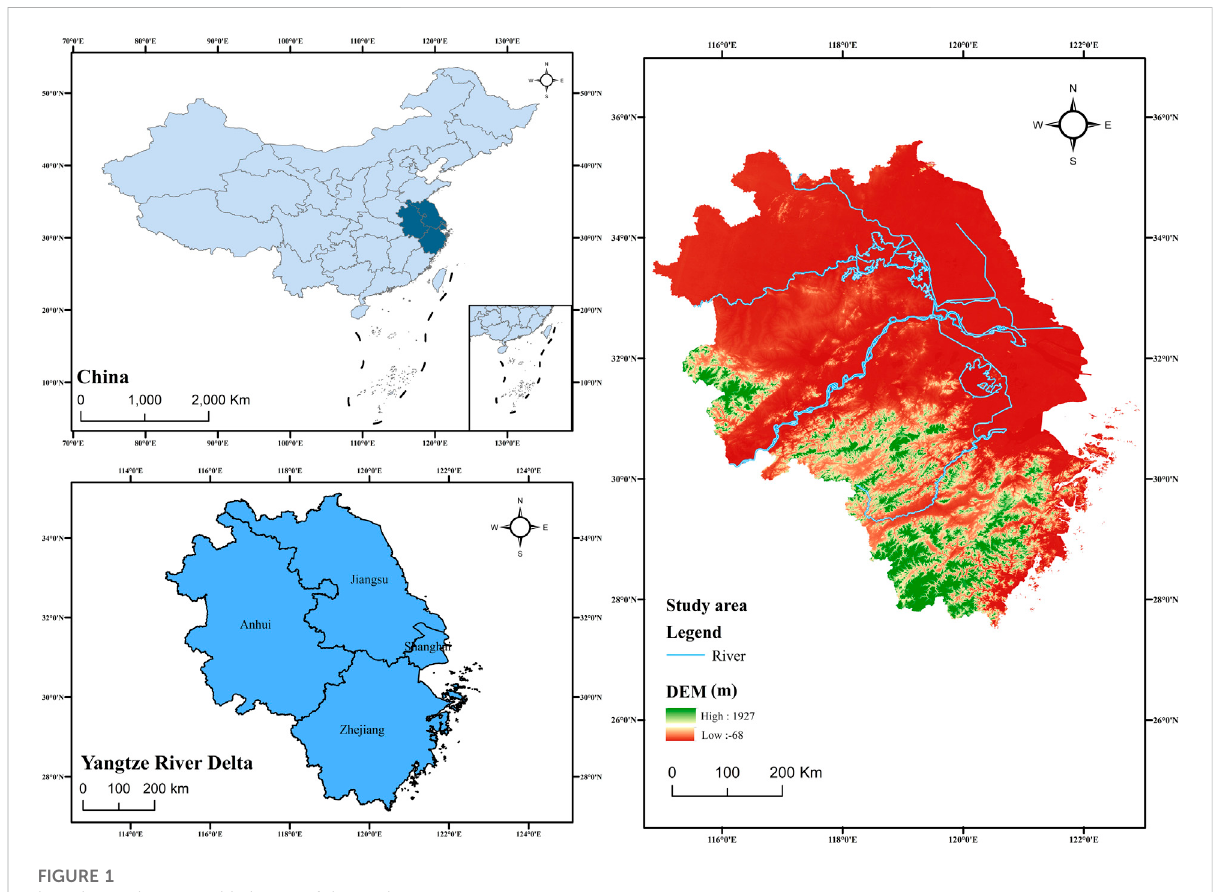
FIGURE 1 Location and topographic layout of the study